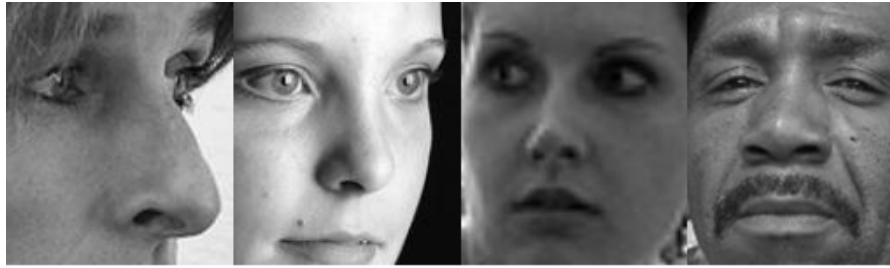
Figure 4. Example images taken from the AFLW dataset [12]. Table 1. Comparison of the key features and image labels of the AFLW, BFD, CelebA, and KDEF datasets.